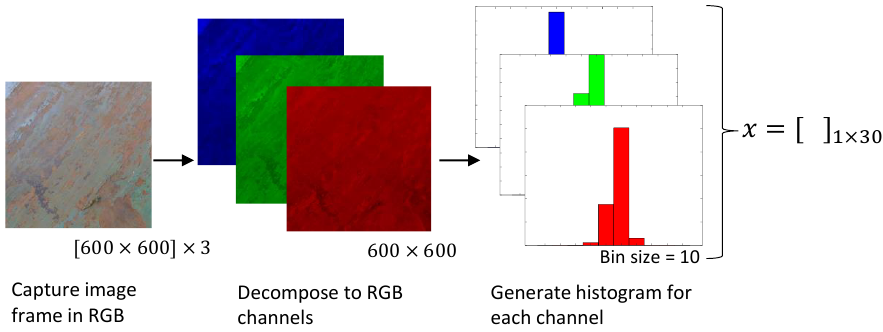
Figure 4. Steps of image processing for feature